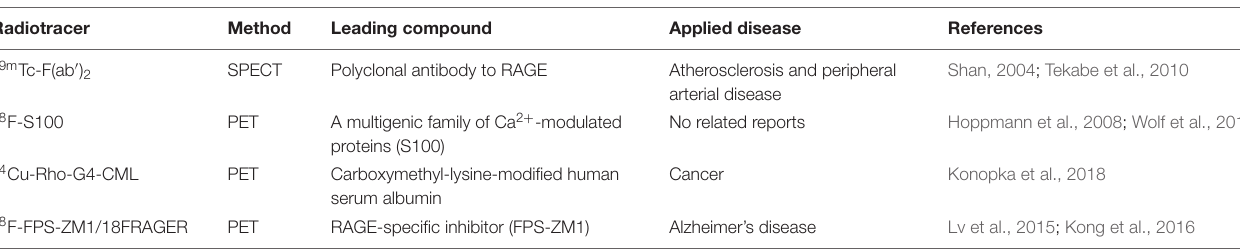
TABLE 2 | PET and SPECT radioligands for imaging